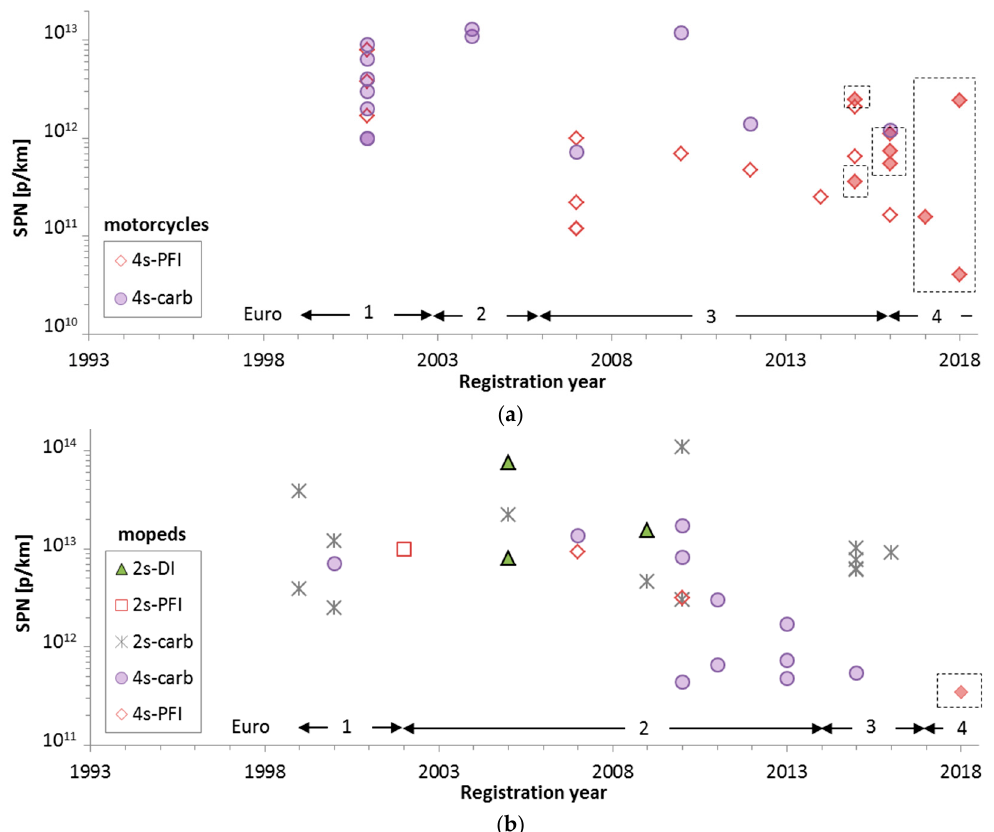
Figure 6. Solid particle number (SPN) emissions from the literature (details in text) for ( a ) motorcycles and ( b ) mopeds with 2-stroke (2s) or 4-stroke (4s) engines with carburettor (carb), direct injection (DI) or port fuel injection (PFI). The vehicles of this study are in dotted boxes.